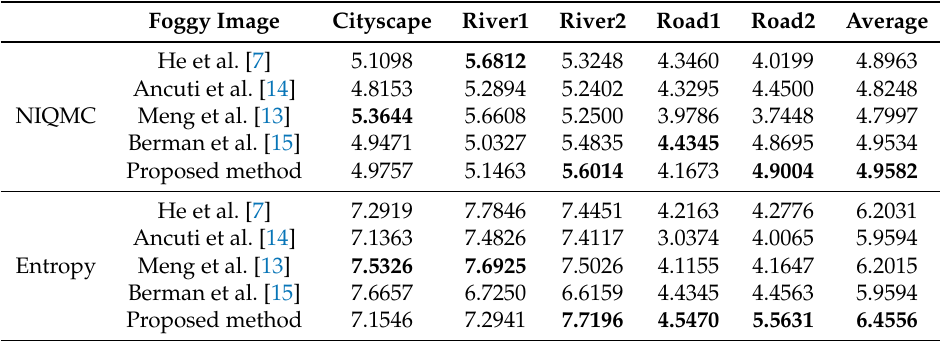
Table 1. Quantitative results for each method using stereo images. NIQMC: no-reference image quality metric for contrast distortion.